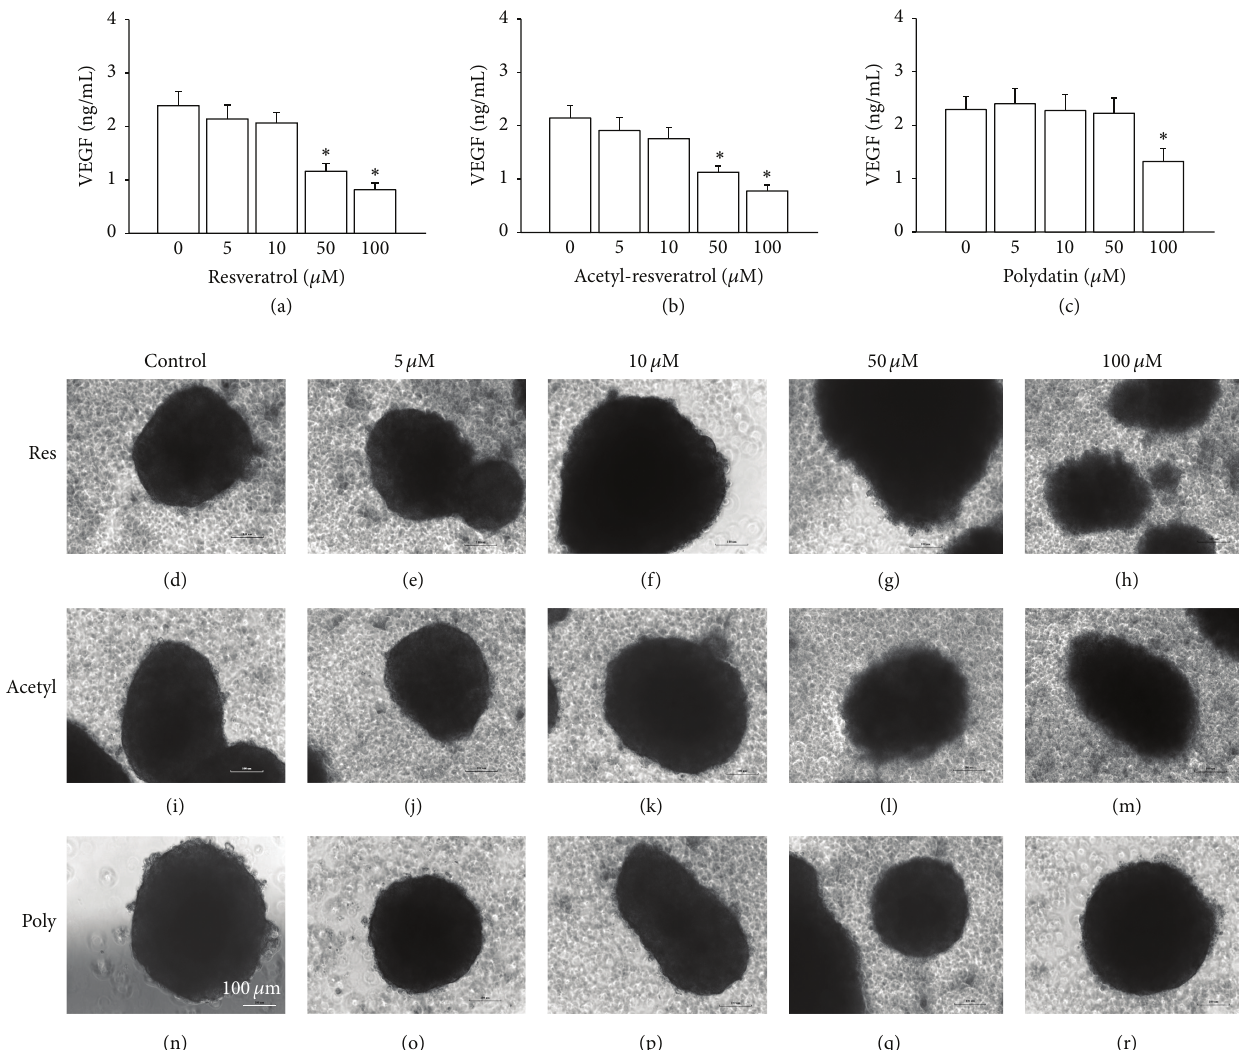
Figure 7: The secretion of vascular endothelial growth factor (VEGF) of SKOV-3 cell aggregates (a–c) and the morphology of OVCAR-8 3D spheroids (d–r). Higher doses of resveratrol (a), acetyl-resveratrol (b), and polydatin (c) significantly reduced the secretion of VEGF. High concentrations of resveratrol (g and h) and acetyl-resveratrol (l and m) caused the irregular rims of spheroids. Polydatin (q and r) did not show any effect. ∗ refers to statistically significant as 𝑝 value less than 0.05 compared to the